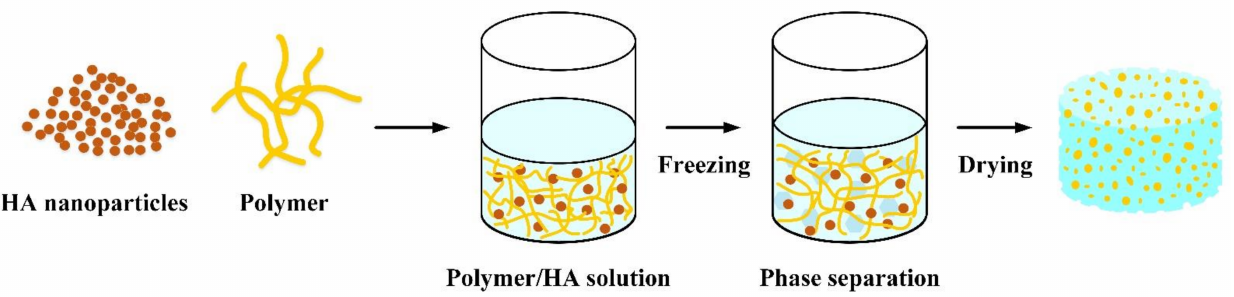
Figure 5. Schematic diagram of the preparation of porous scaffolds of polymers composite